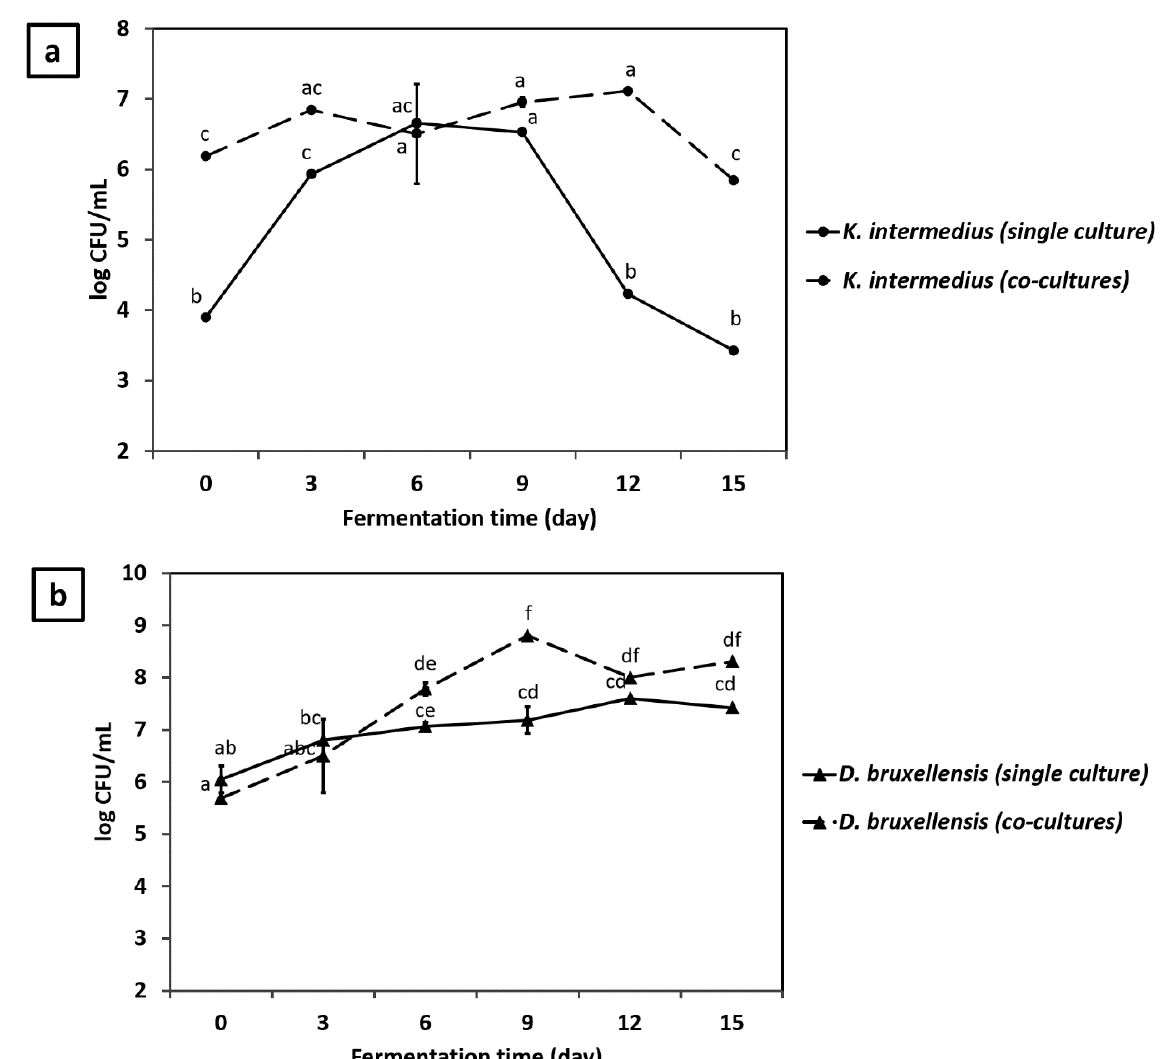
Figure 2. The growth of ( a ) K. intermedius and ( b ) D. bruxellensis as single and co-culture. Culture conditions: media composition, 150 g/L molasses, 500 mg/L caffeine, acetate buffer (200 mM, pH 4.75); inoculum size, 10% v / v ; K. intermedius : D. bruxellensis ratio, 1:1; temperature, 30 °C. Means with different letters are significantly different ( p < 0.05).